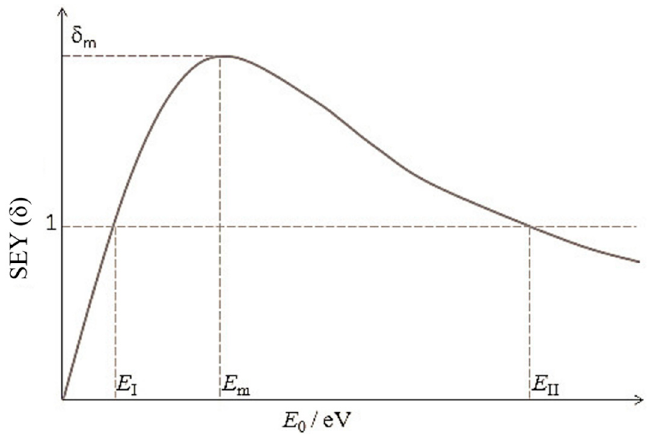
Figure 4. Schematic illustration for the variation of SEY with primary electron beam energy E 0 . The figure is reproduced from reference [15].